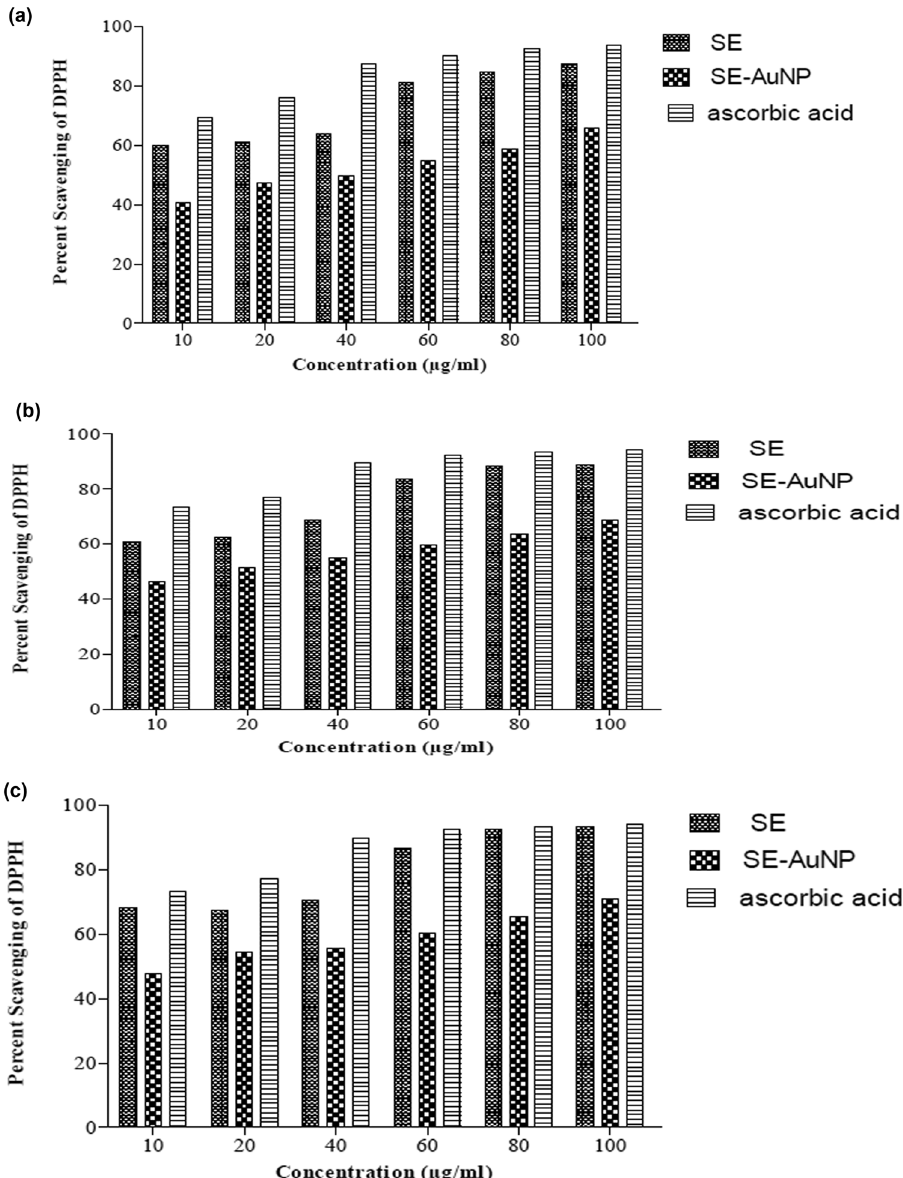
Figure 10: DPPH radical scavenging activity of SE, SE - mediated AuNPs, and ascorbic acid ( standard ) under di ff erent concentrations at ( a ) 30 min of incubation time, ( b ) 60 min of incubation time, and ( c ) 90 min of incubation